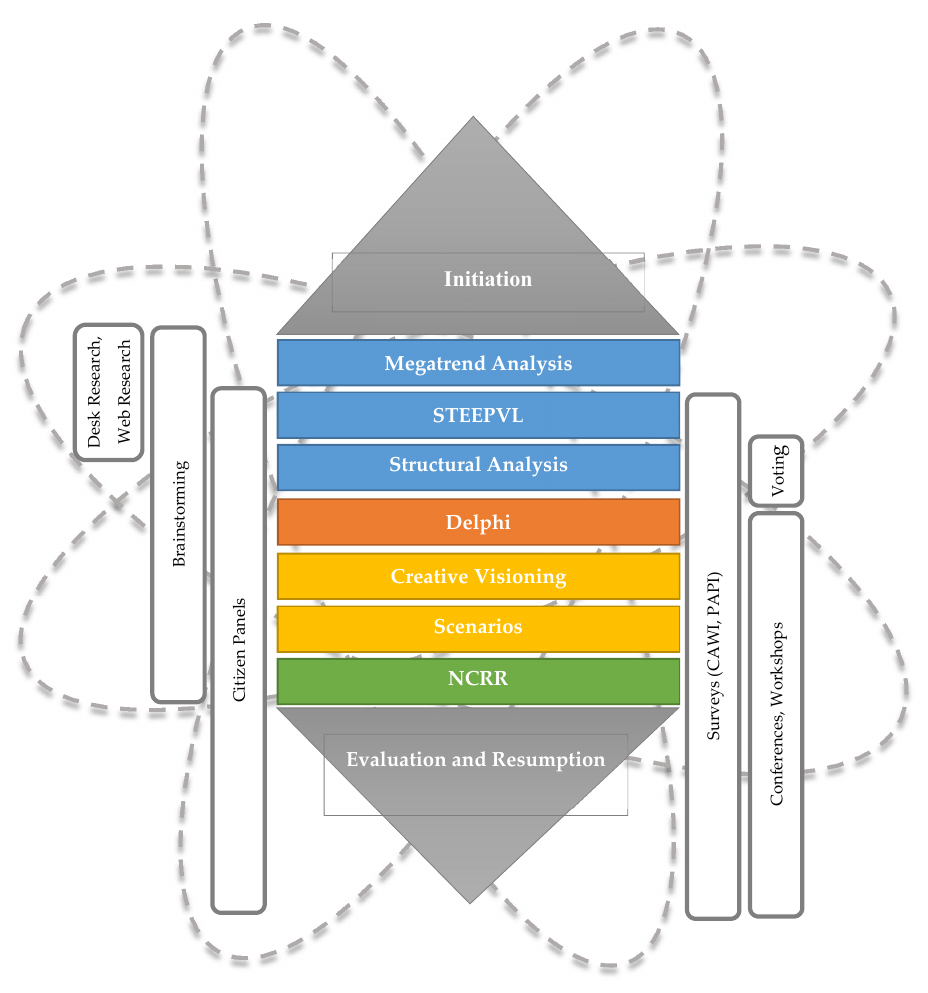
Figure 3. General scheme of methodology for planning and implementation of the vision of smart city development.